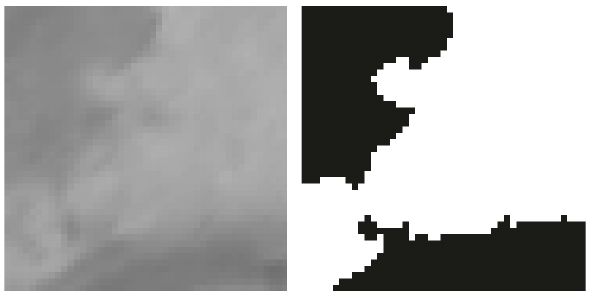
Figure 5: NDVI map on which a threshold is used to obtain the tiles that contain vegetation. Threshold is set at